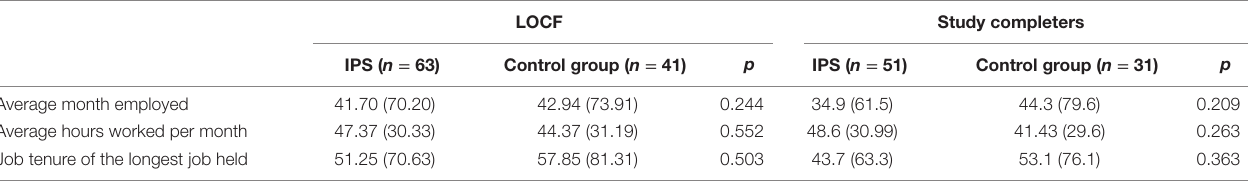
TaBle 4 | results of secondary outcome